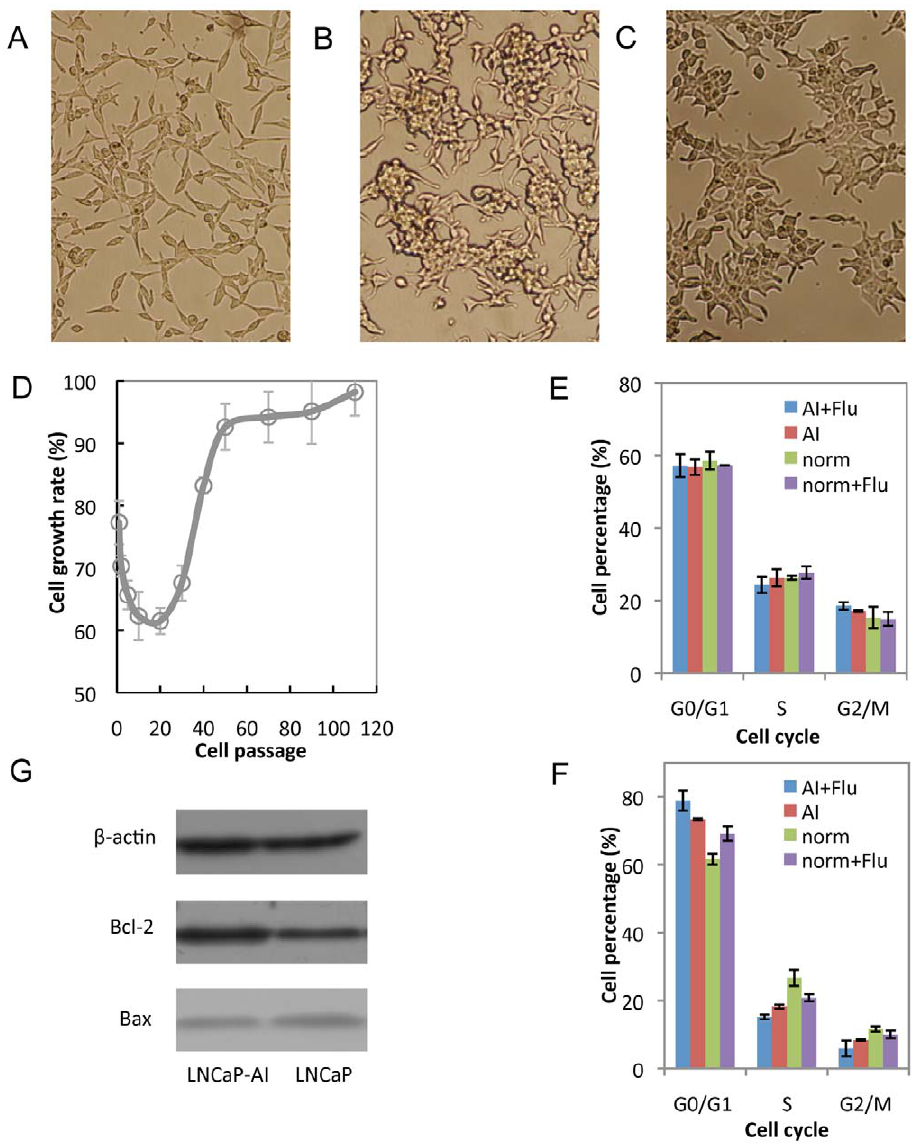
Figure 1. Changes in the biological characteristics of LNCaP cell line from androgen-dependent to androgen-independent. (A) The morphology of parental LNCaP cells, which were cultured in regular medium for 3 days. (B) Neuroendocrine phenotype of LNCaP cells. LNCaP cells were maintained in androgen-depleted medium and cultured for 3 passages. (C) Morphology of LNCaP-AI cells. LNCaP cells were cultured with flutamide in androgen-depleted medium for 110 passages. (D) The cell growth rates of androgen-depleted cultured LNCaP cells at different passages when grown in androgen deprivation environment. (E–F) The effects of androgen-depleted environment and flutamide on LNCaP-AI (E) and LNCaP- FGC (F) cell cycle. (AI: androgen-depleted medium; Flu: 1.0 6 10 2 7 mol/L of flutamide; norm: regular medium). (G) Bcl-2 and Bax expression in LNCaP and LNCaP-AI cells.